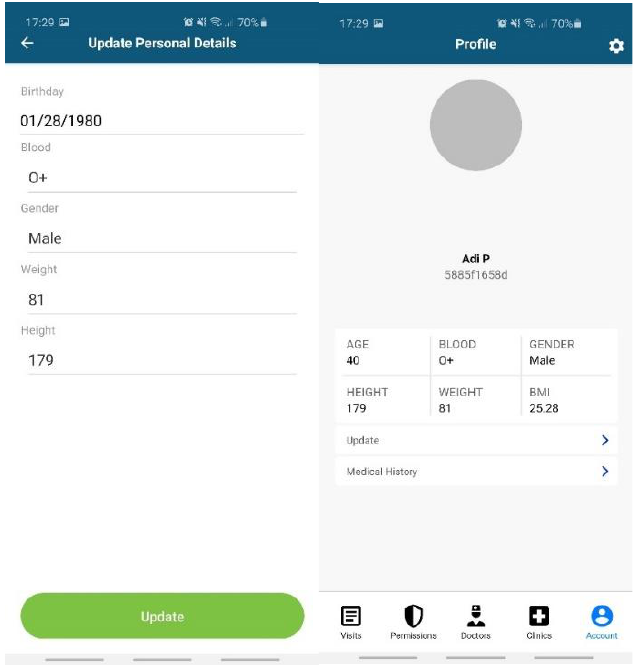
Figure 7. Data entered by the patient in PatientDataChain .